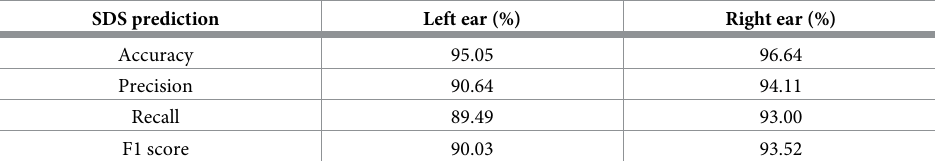
Table 3. Accuracy, precision, recall and F1 score of our SDS prediction model for the right and left